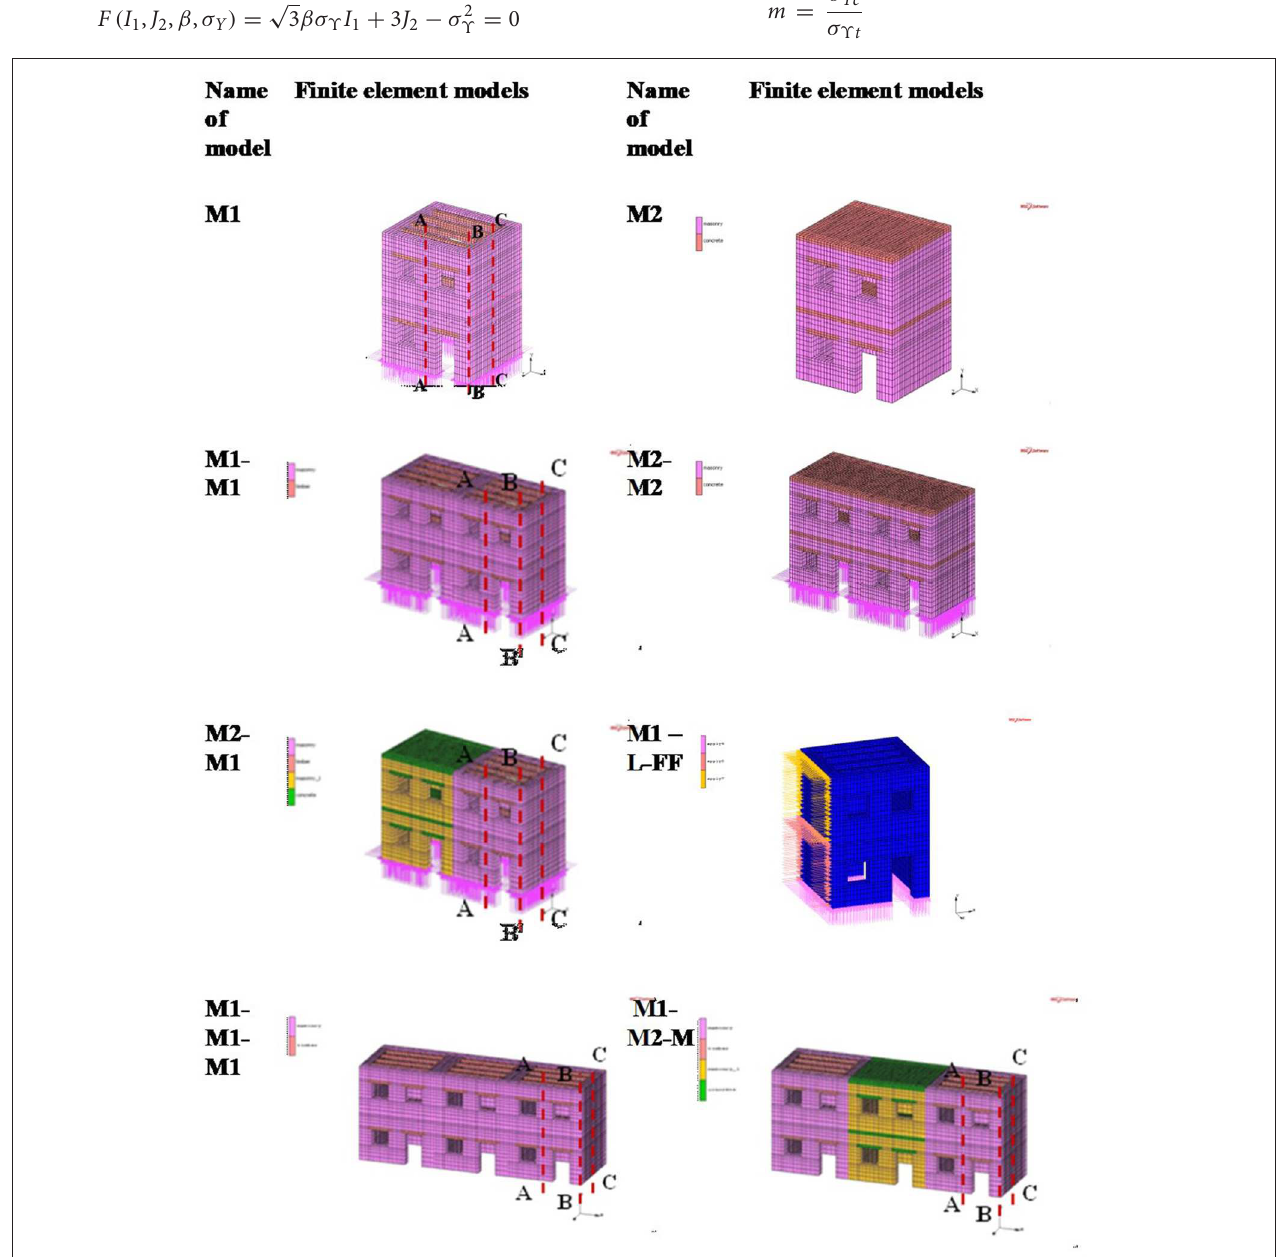
FIGURE 5 | Structural system and modeling of the finite element models.